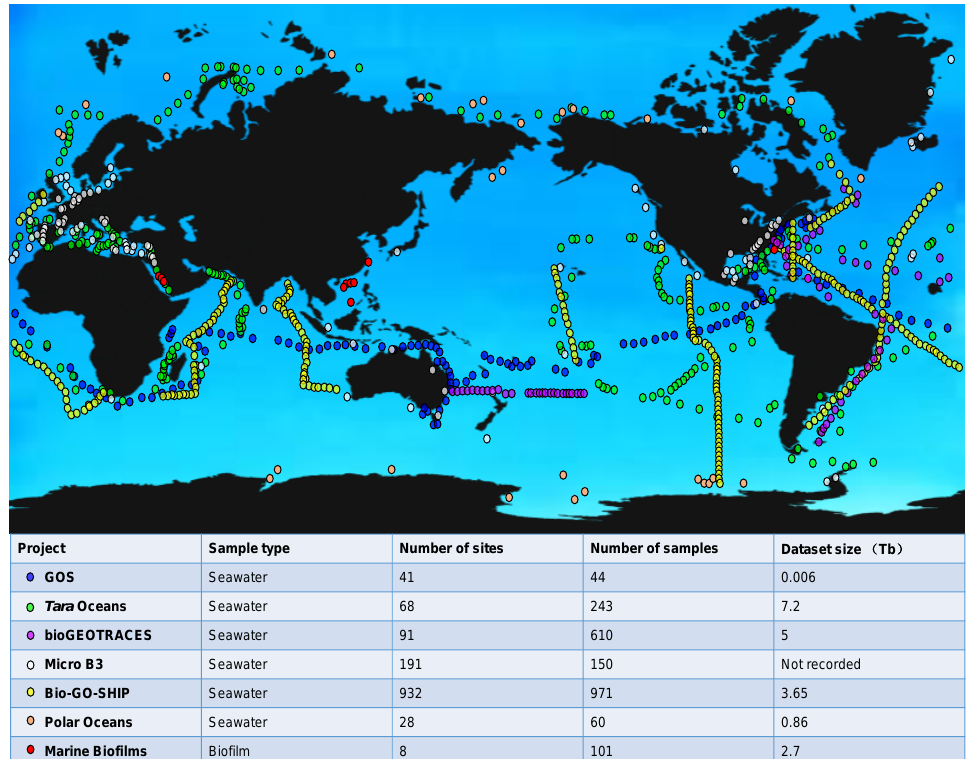
Figure 2. Summary of the global microbiome information. The sampling sites are plotted in the global ocean map. The launch time of these projects [36–38,65,66,69–73], number of sampling sites, number of samples, and the dataset size are summarized in the bottom panel.